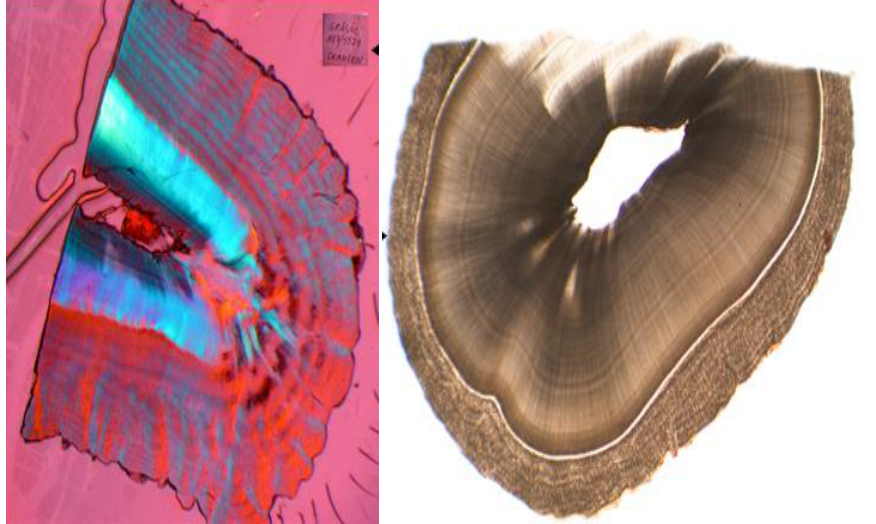
Fig. 3. Grey seal ( Halichoerus grypus ) untreated tooth sections, sections in the longitudinal plane and viewed under polarised light (left) and in the transverse plane viewed under plain light